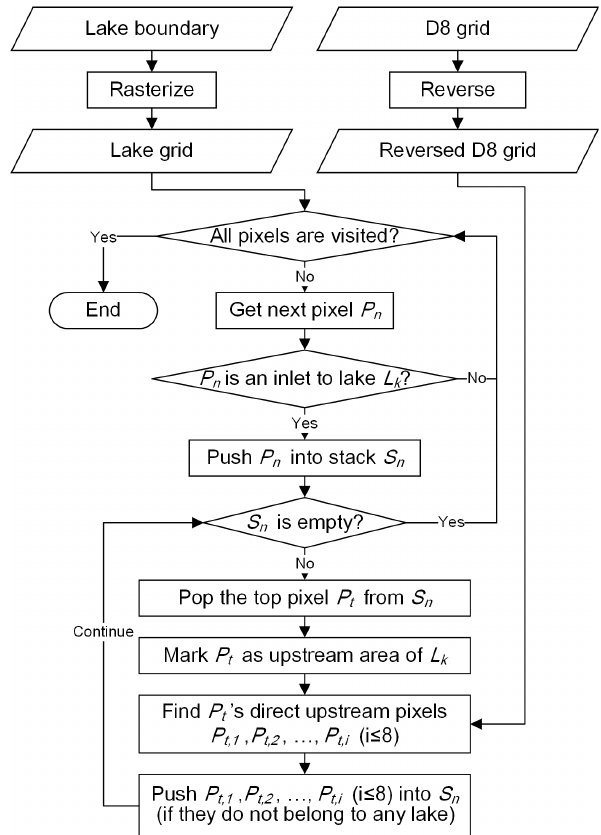
Figure 4. Flowchart for lake catchment